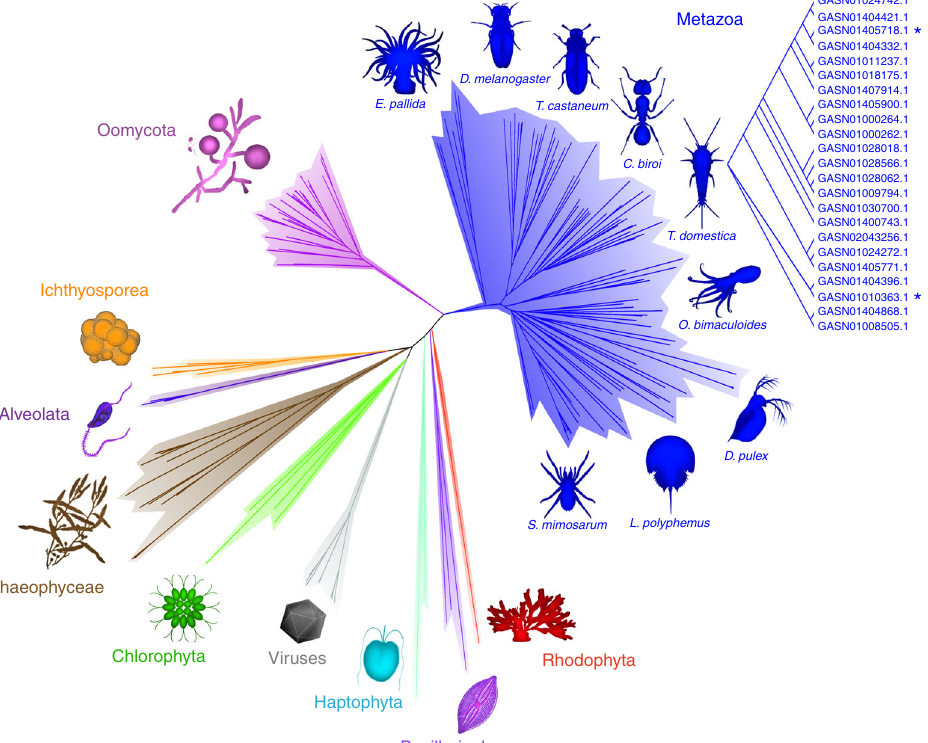
Fig. 2 Radial phylogram of the AA15 family across Taxa. Sequences were identi fi ed in the genomes of animals (Metazoa), Oomycota, multicellular algae (Phaeophyceae, Rhodophyta), unicellular algae (Bacillariophyceae, Haptophyta, Chlorophyta, Alveolata), Ichthyosporea and viruses. The fi gure shows some examples of animal species (cnidaria, molluscs, insects, crustaceans, chelicerates) possessing AA15 sequences; 23 full-length LPMO domains were identi fi ed in the transcriptome of T . domestica . Asterisks mark the two sequences (GASN01405718.1 and GASN01010363.1, named Td AA15A and Td AA15B in this manuscript) that were successfully expressed in Escherichia coli and characterized. See Methods for more